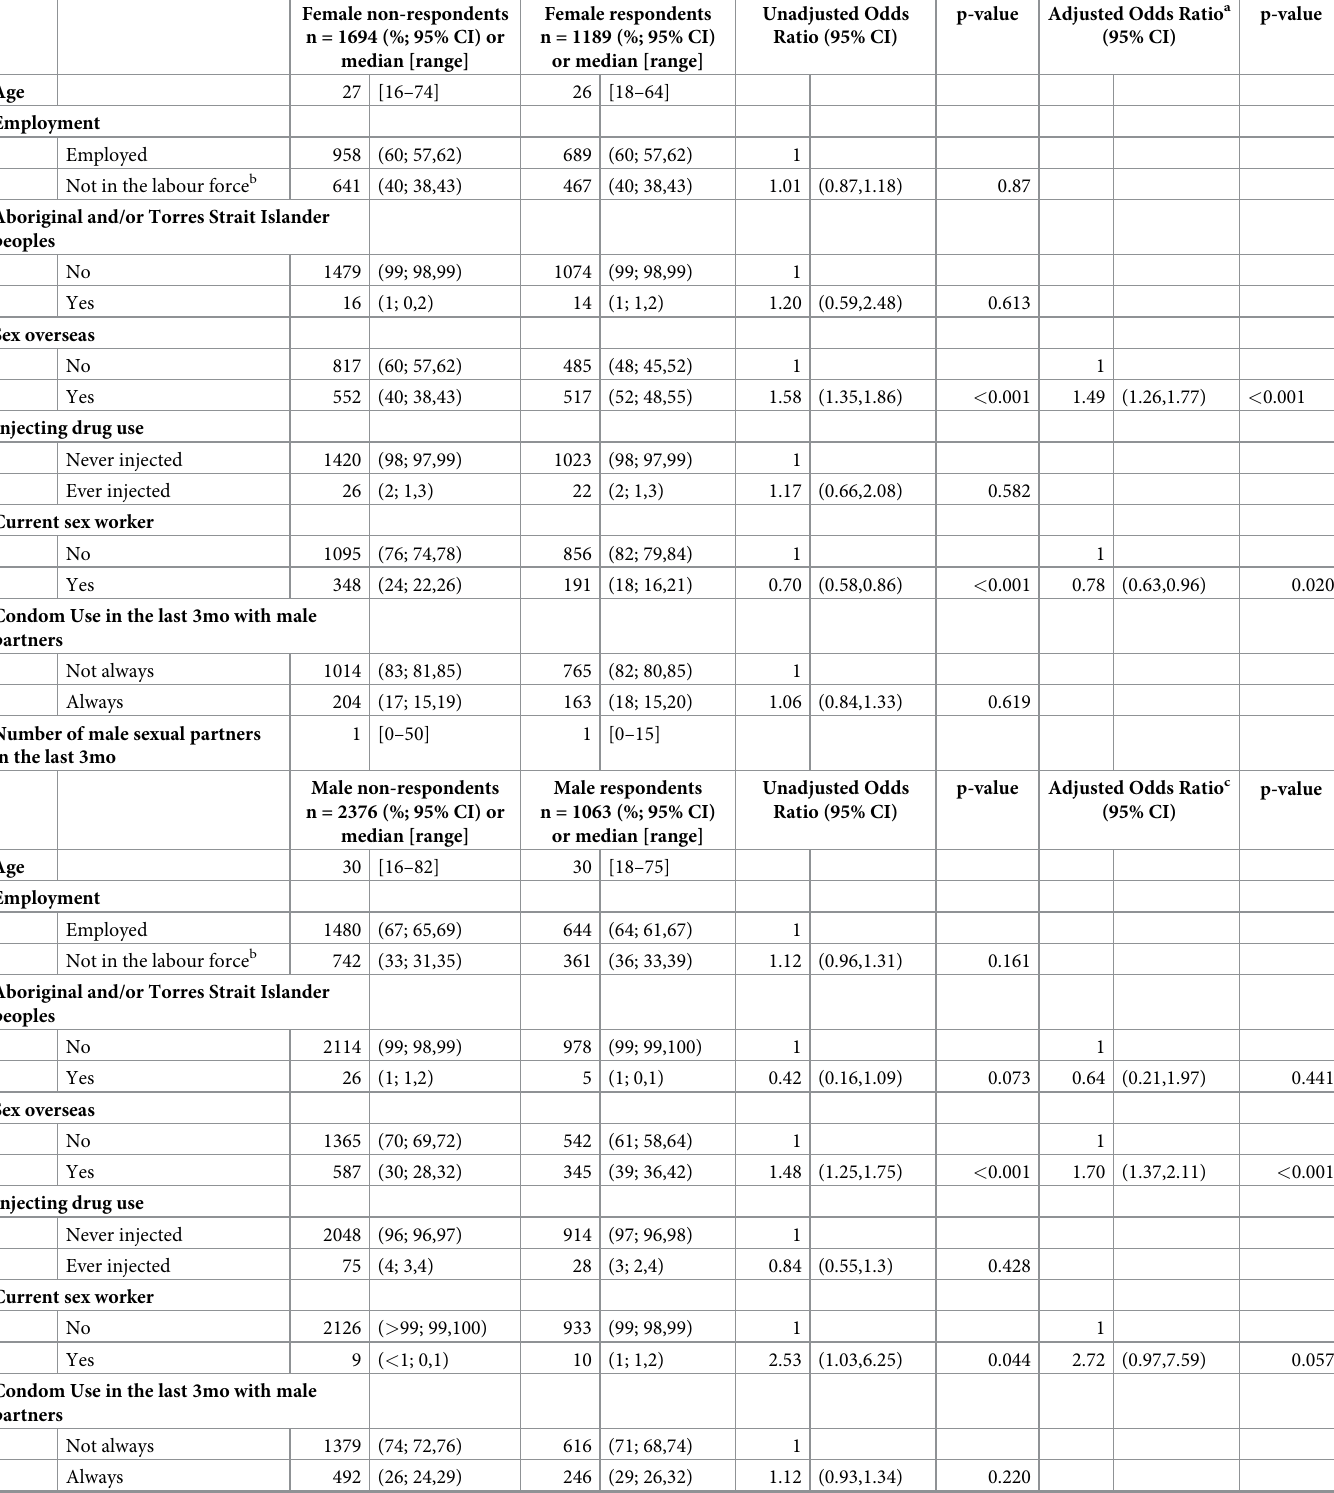
Table 1. Demographics and epidemiological features of respondents versus non-respondents to survey on rates of non-consensual removal of condoms (stealthing) in a STI clinic (N =